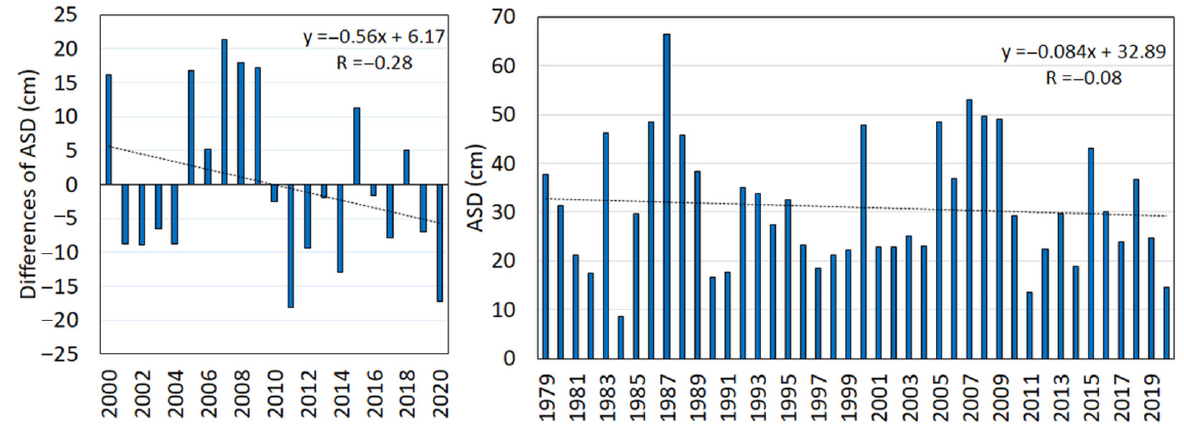
Figure 3. The difference of average snow depth (ASD) from its average value of the period 2000–2020 (31.7 cm) indicates a decreasing trend by − 0.56 cm year − 1 ( left ), which is, however, not seen in the long-term data ( − 0.084 cm year − 1 ) between 1979–2020 ( right ).